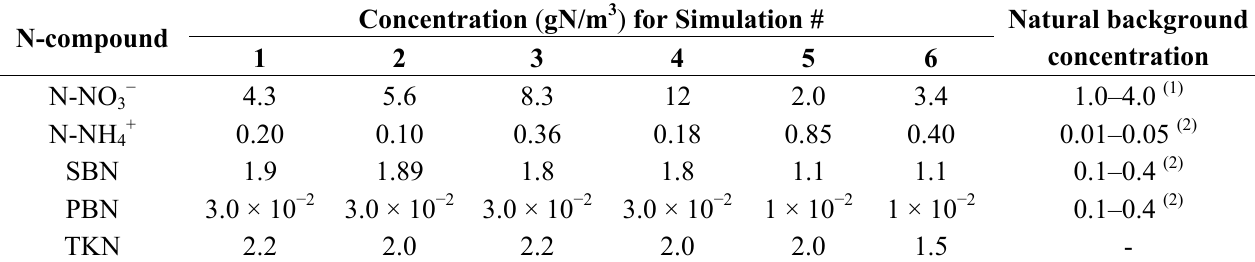
Table 5. Concentrations of the different N-compounds in the effluent for all simulations performed and the naturally occurring background concentrations of the particular N-compounds in